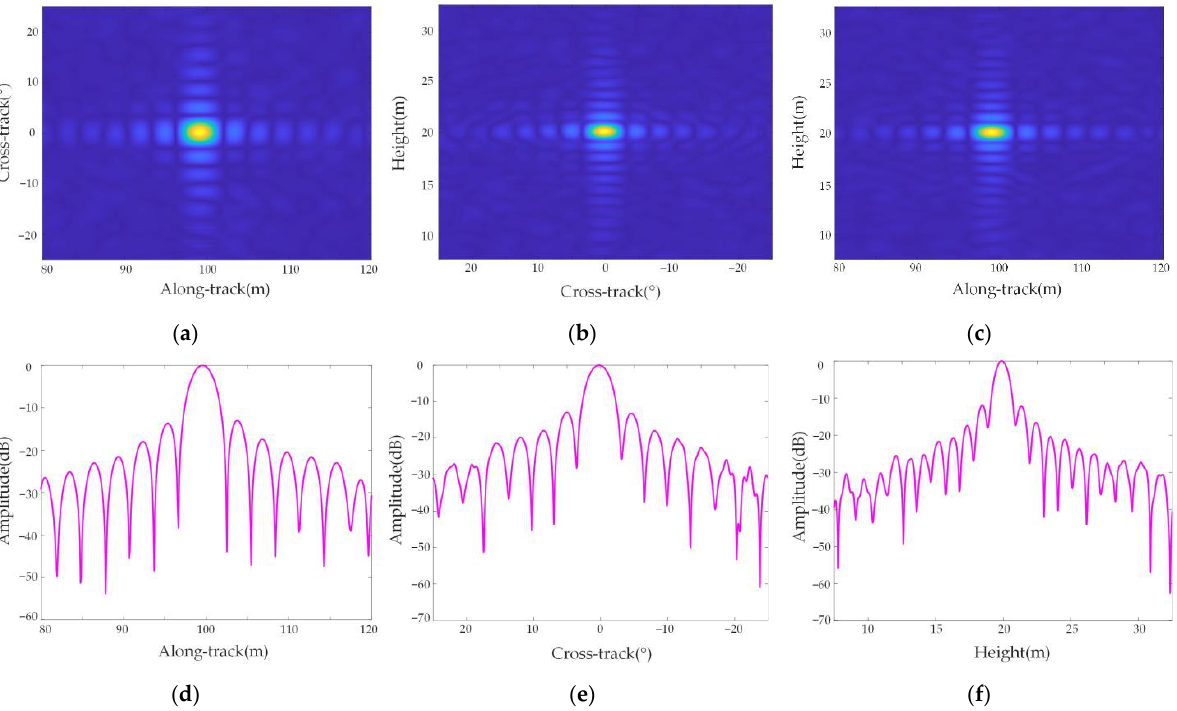
Figure 11. Point P9 3D sectional view and point target quality analysis. ( a ) Along-track-cross-track sectional view; ( b ) cross track–height direction section view; ( c ) along track–height direction section view; ( d ) along-track PSLR; ( e ) cross-track PSLR; ( f ) height PSLR.